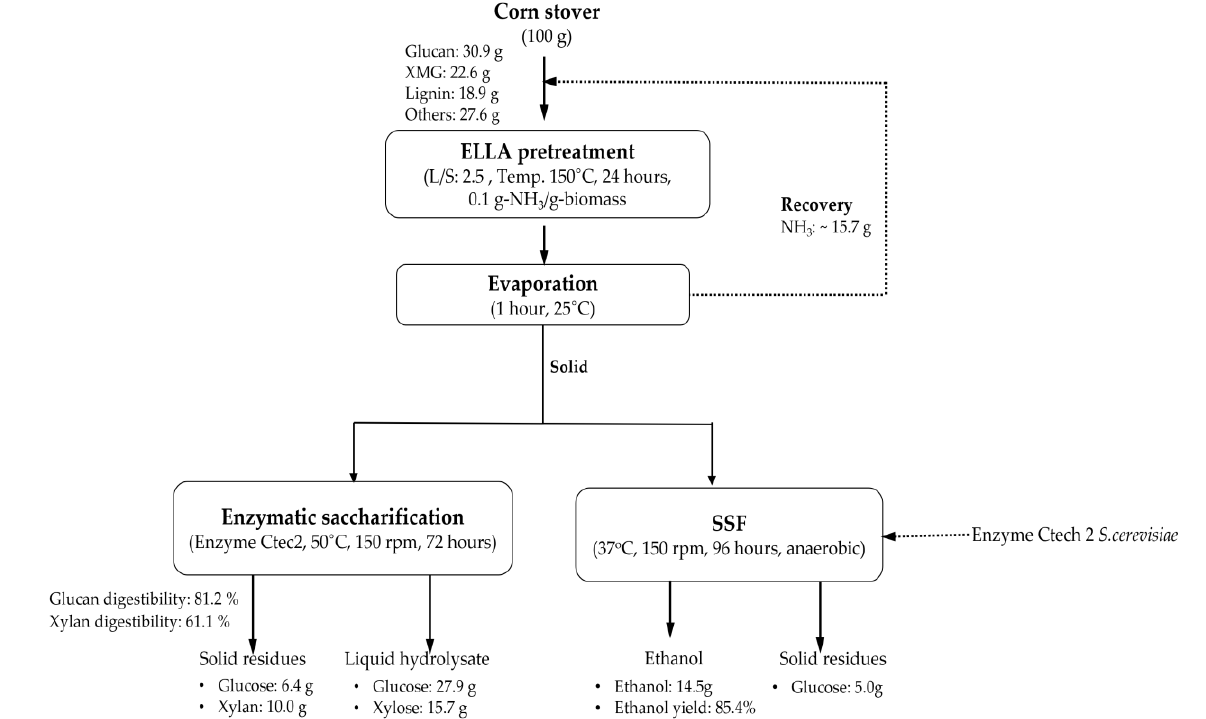
Figure 7. Schematic diagram and mass balance of production process for ethanol and glucose using ELLA pretreatment and SSF.